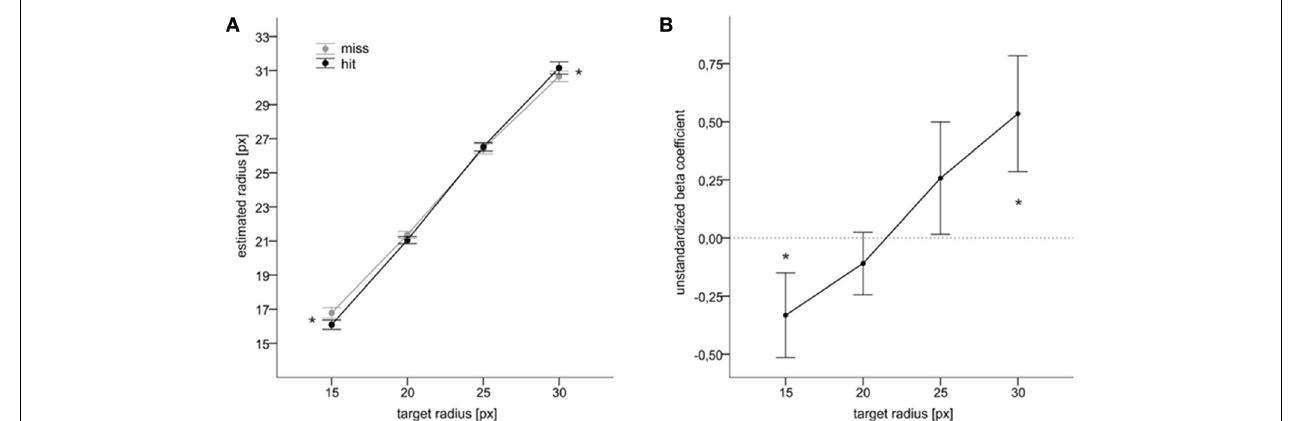
FIGURE 2 | Main results of Experiment 1. (A) Mean judgments of target radius as a function of target size and of action success. (B) Mean unstandardized beta coefficients indicating an impact of